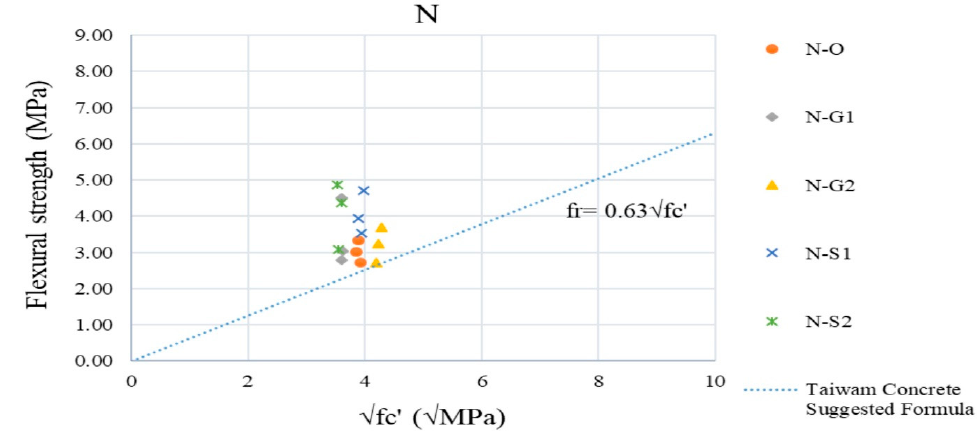
Figure 13. Relationship between flexural strength and √ fc ′ for ordinary pervious concrete.